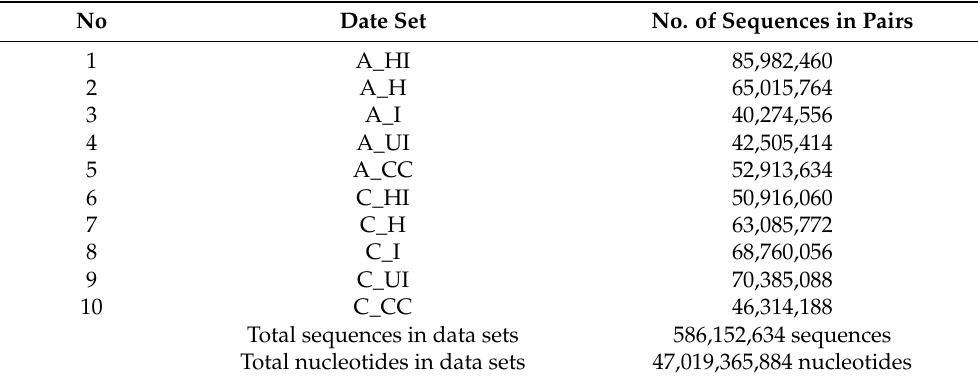
Table 1. Number of paired-end sequences generated in mRNA sequencing.